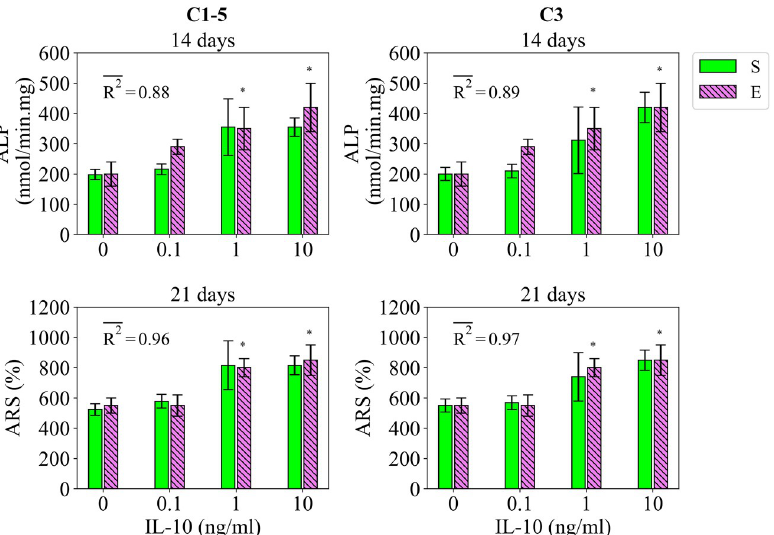
Fig 4. Fits of the model calibrated by C1-5 and C3 to the empirical data of study 3 for the case of IL-10. Bars indicate the simulations (S) and the corresponding empirical data (E). The quantities of ALP and ARS are reported at day 14 and 21, respectively. The error bars on the empirical data shows the standard deviations. The error bars on the simulation results show the standard deviations obtained during SSIP, i.e. 15% alteration in the estimated parameter values. Stars indicate the statistically significant differences between values given for the empirical data compared to the control, i.e. the applied concentration of 0 ng/ml (p < 0.05 = � ). R 2 is the average fitness value of the simulations for the given measurement item.